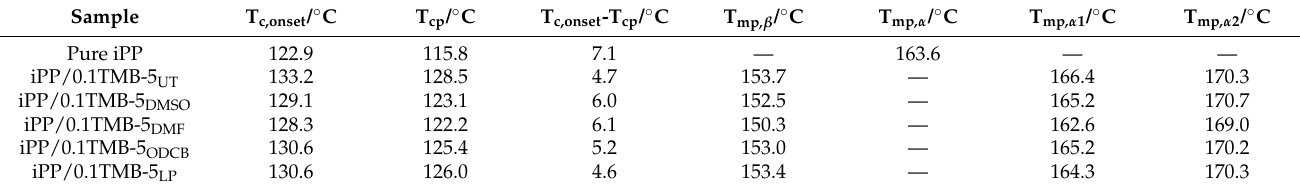
Figure 7. ( a ) DSC cooling curves after a 200 ℃ heating of 5 min to erase the thermal and mechanical history and ( b ) the subsequent melting curves of pure iPP and TMB-5 nucleated iPP (iPP/0.1TMB-5 UT , iPP/0.1TMB-5 DMSO , iPP/0.1TMB-5 DMF , iPP/0.1TMB-5 ODCB and iPP/0.1TMB-5 LP ). The NA content is 0.1 wt%, both the heating and cooling rate are 10 ℃ /min. Table 1. Crystallization and melting parameters of pure iPP and iPP/0.1TMB-5 specimens from DSC curves.